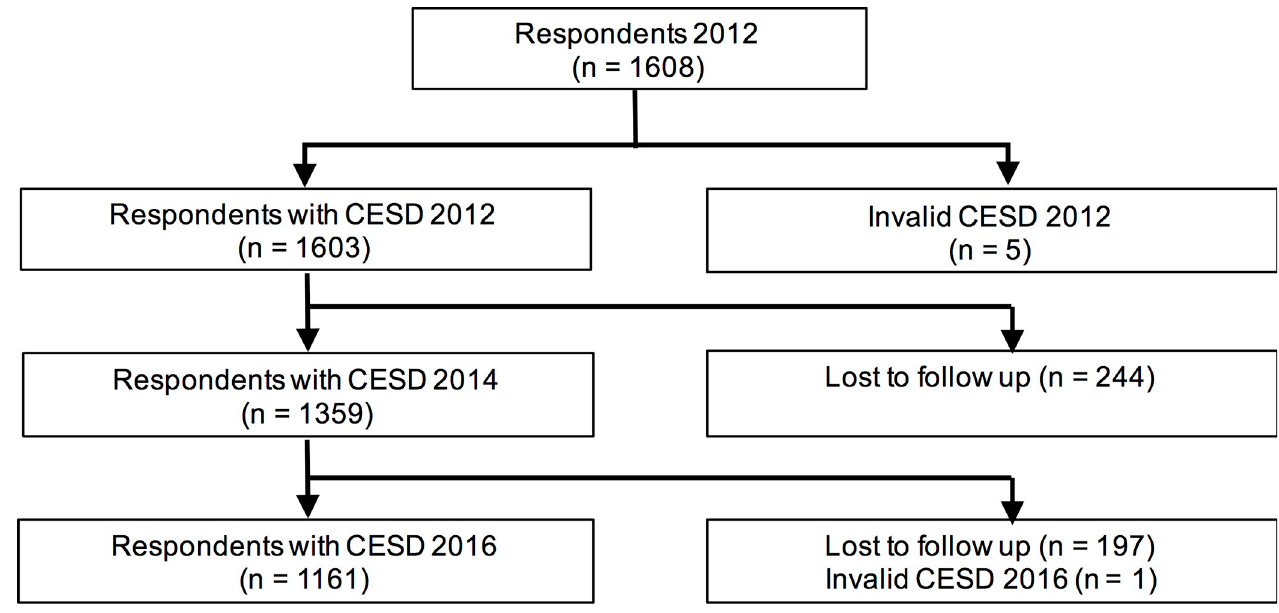
Fig 1. Flowchart illustrating respondent recruitment and withdrawal.